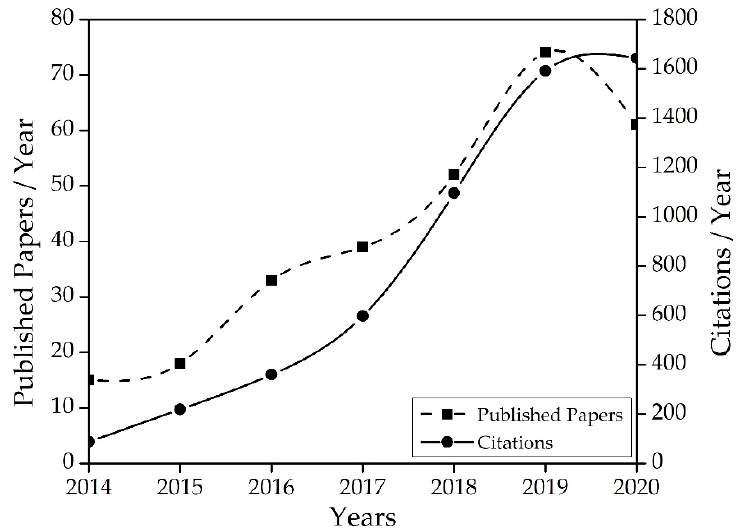
Figure 1. Citations and number of papers published using the keywords ‘hydrochar’ and ‘fuel’ for the period 2014–2020.